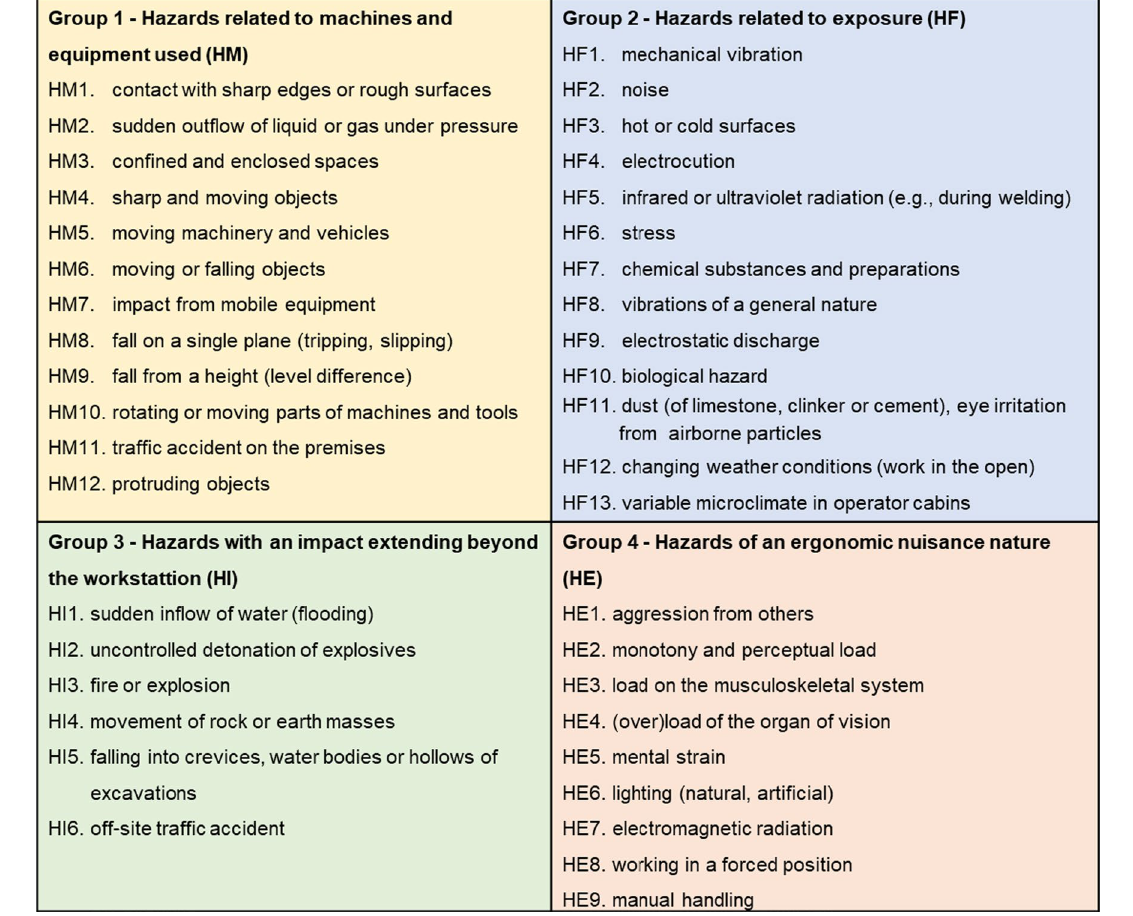
Fig. 1 The list of identified hazards occurring during the implementation of the technological process in the open-pit